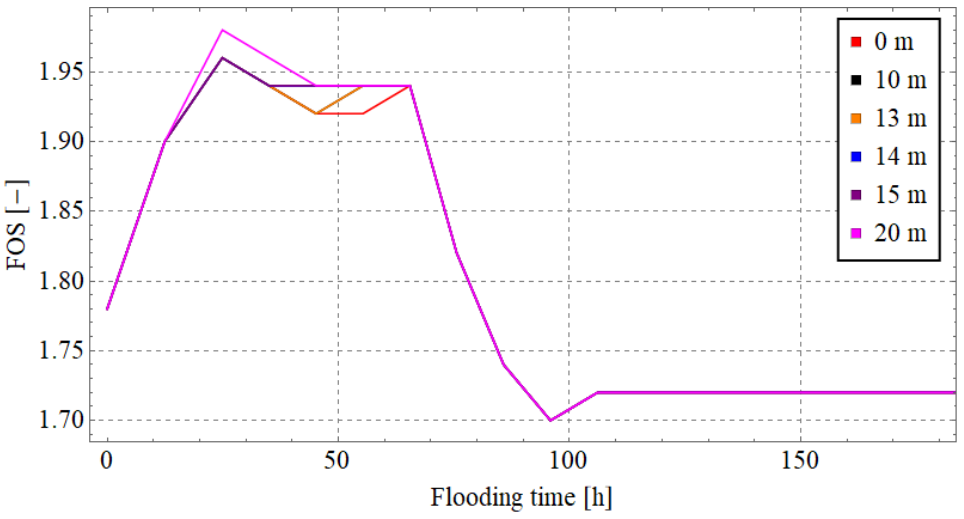
Figure 14: Evolution of the factor of safety in time during flood wave passage for different depths of the anti-filtration